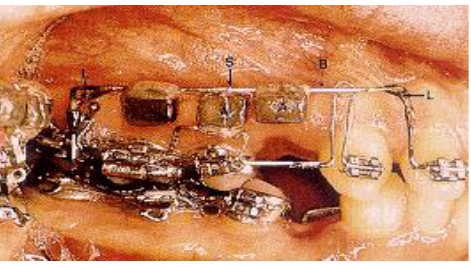
Figure 21: Canine retraction with rare earth